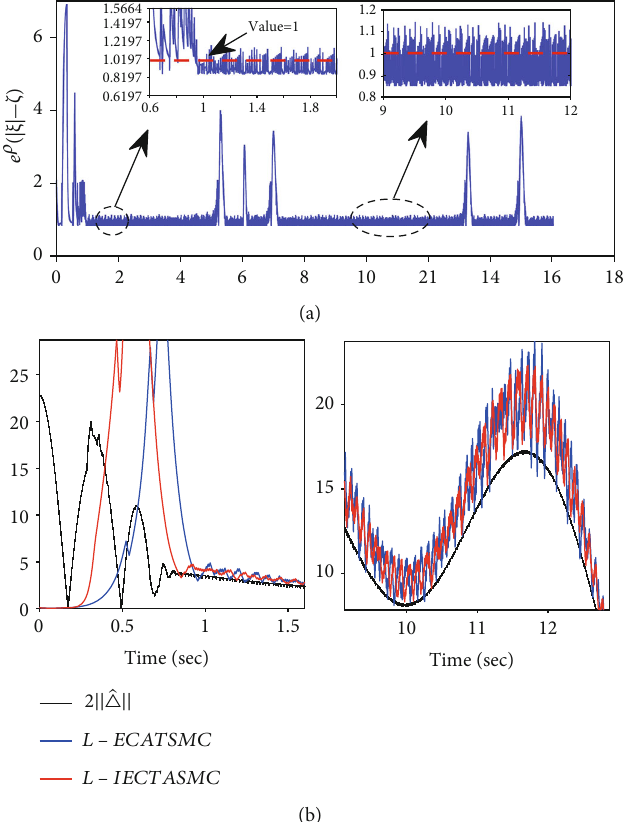
Figure 5: Comparison between IECATSMC and